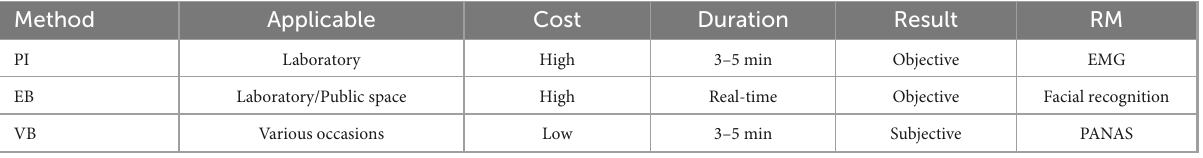
TABLE 1 Comparison of different emotion recognition